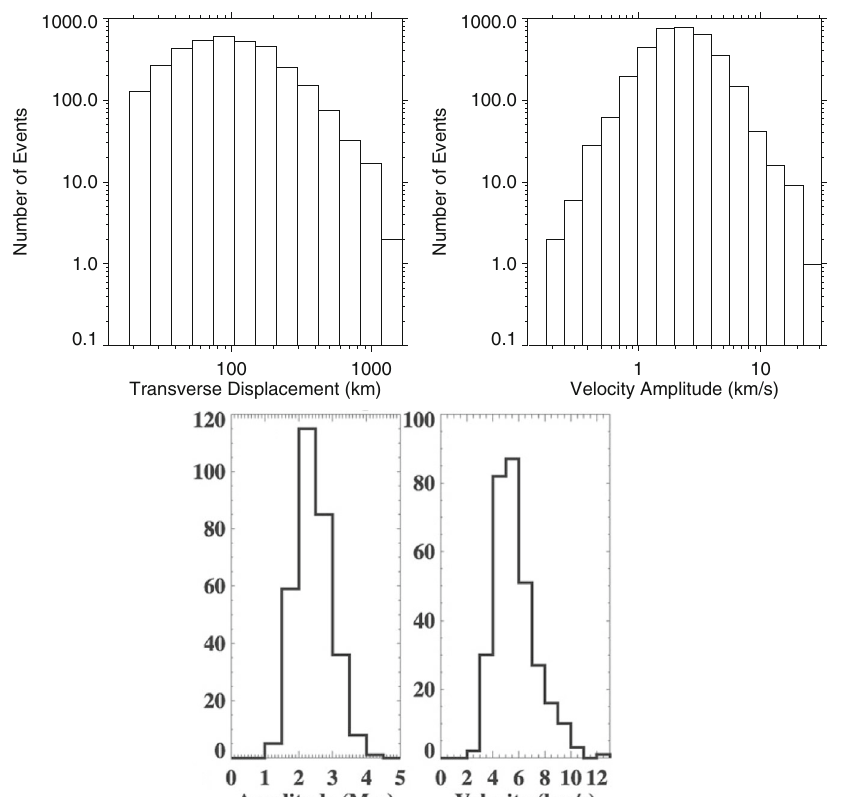
Fig. 12 Top: Hinode/SOT H α observation of transverse thread oscillations in a quiescent prominence. Image reproduced with permission from Hillier et al. (2013), copyright by AAS. Bottom: SDO/AIA 171 Å observationoftransverseoscillationsofbarbbelongingtoapolarcrownprominence.Imagereproducedwith permission from Li and Zhang (2013), copyright by Springer. Histograms of (left) displacement amplitude and (right) velocity